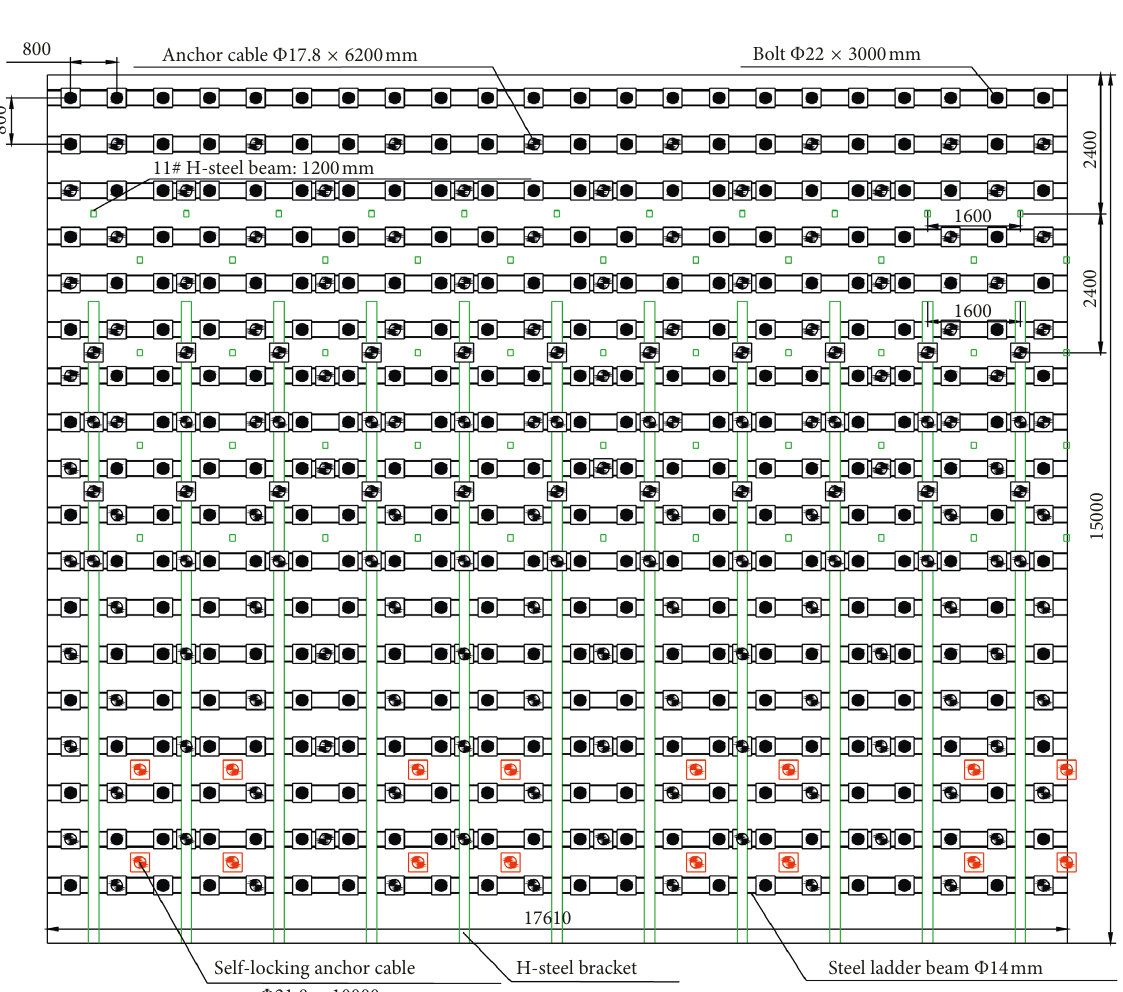
Figure 13: Expanded view of the supporting scheme for the coal